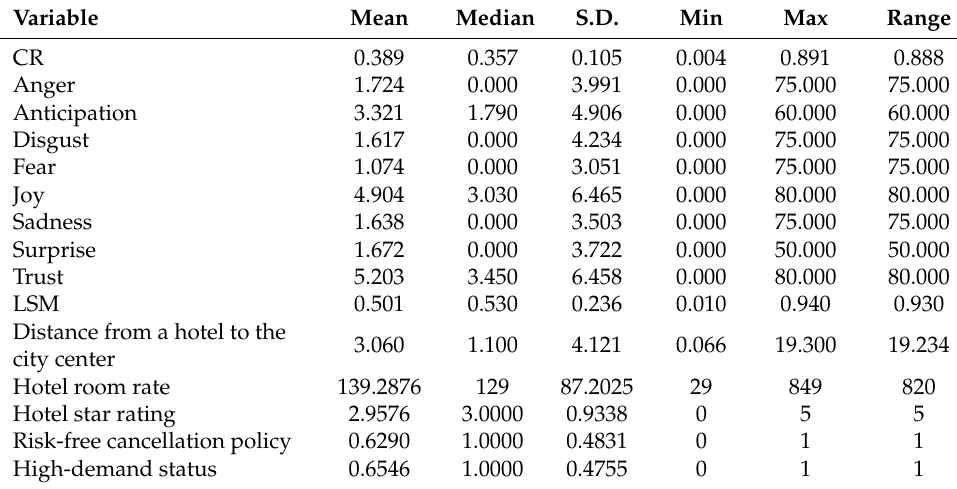
Table 3. Descriptive statistic results of the